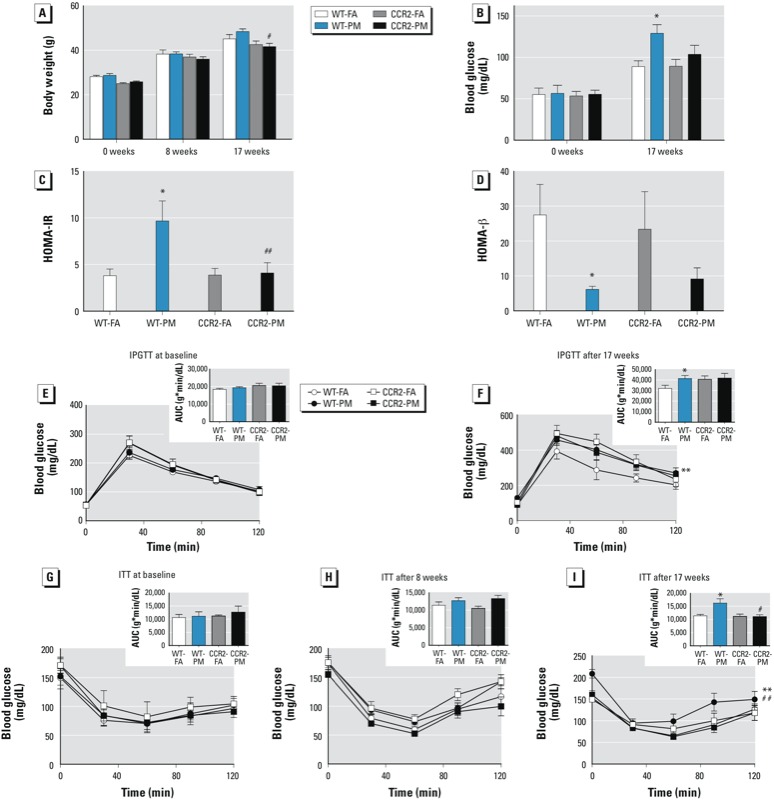
Effect of PM2.5 exposure and HFD on glucose homeostasis in WT and CCR2–/– mice; experiments were performed at baseline and after 8 and 17 weeks of exposure to PM2.5 or FA. (A–B) Body weight (A) and fasting blood glucose (B). (C–D) HOMA-IR (C) and HOMA-β (D) after 17 weeks of exposure. (E–F) Results of IPGTT in overnight-fasted mice at baseline (E) and after 17 weeks of exposure (F). (G–I) Results of ITT in 4.5‑hr–fasted mice before exposure (G) and after 8 weeks (H) and 17 weeks (I) of exposure. Insets (E–I) are results of GTT and ITT analyzed by area under the curve (AUC). Values shown are mean ± SE of 7–9 mice/group.
*p < 0.05, and **p < 0.01, compared with the WT‑FA group. #p < 0.05, and ##p < 0.01, compared with the WT‑PM group.